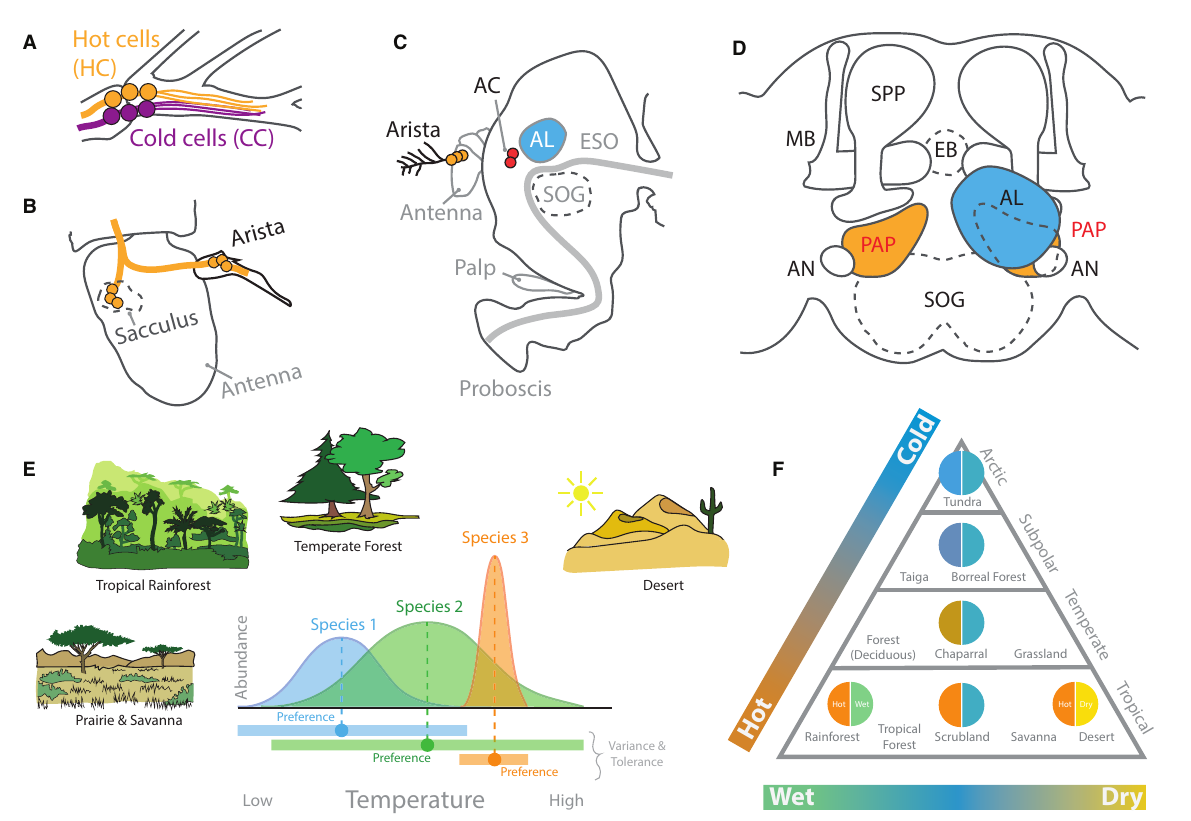
FIGURE9 Thermosensation and hygrosensation in D. melanogaster . (A) Six neurons at the base of the arista on the fly antenna detect hot and cold stimulations. (B) Neurons within the sacculus inside the third antennal segment also contribute to both temperature and humidity detection. These merge with innervation from the arista before heading into the central brain. (C) A side view of the D. melanogaster head. Neurons from the arista related to heat detection transmit their information to AC neurons in close proximity to the AL and SOG. (D) A frontal view of the central brain structures related to thermal sensory systems, which include primarily the proximal antennal protocerebrum (PAP), named for its proximity to the AL and antennal nerve (AN). The PAP subsequently innervates with the AL, MB, as well as LH in D. melanogaster adults. (E) Hypothetical examples of how fly species can vary in habitat and ecological preferences. Some species may have wider (or more narrow) ranges of acceptable temperatures. These differences may relate to individual or species-level variation in their neurobiology and genomes. (F) A biome triangle of ecological or habitat classifications based on average temperature and humidity levels. Drosophila species are found across huge variations in both thermal and hygrosensation niches in the wild. However, most of what we know comes from only a few species, such as D. melanogaster , which originates from sub-Saharan tropical rainforests, a habitat that is both hot and wet. HC, hot cells; CC, cold cells; AC, anterior cell neurons; ESO, esophagus; SOG, suboesophageal ganglion; MB, mushroom body; SPP, super peduncular protocerebrum; EB, ellipsoid body